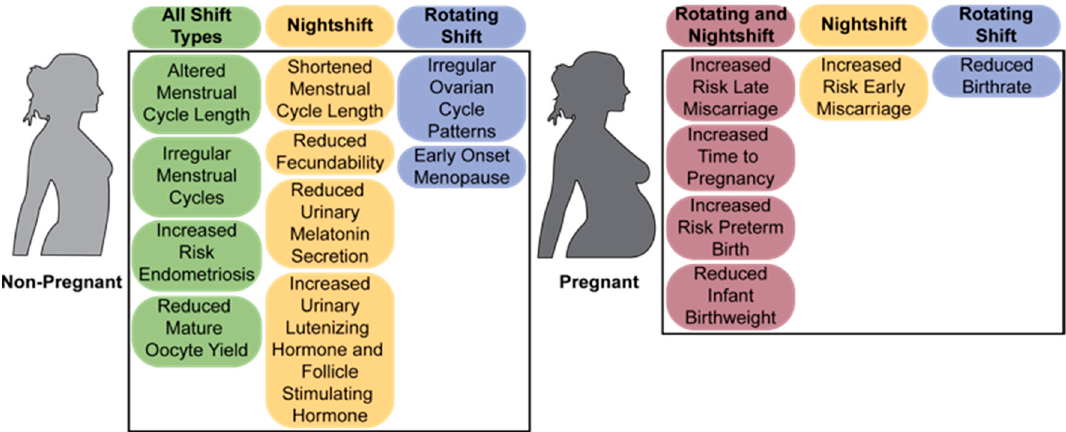
Figure 2. Summary of the impact of shiftwork on reproductive function in women. Effects of shiftwork on female reproduction in non-pregnant (top) and pregnant (bottom) women. Risks associated with different categories of shiftwork are categorized by colors corresponding to the legend at the top, where green indicates all shift types (nightshift, evening shift, and rotating shift), yellow is nightshift, blue is rotating shifts, and purple is both rotating and